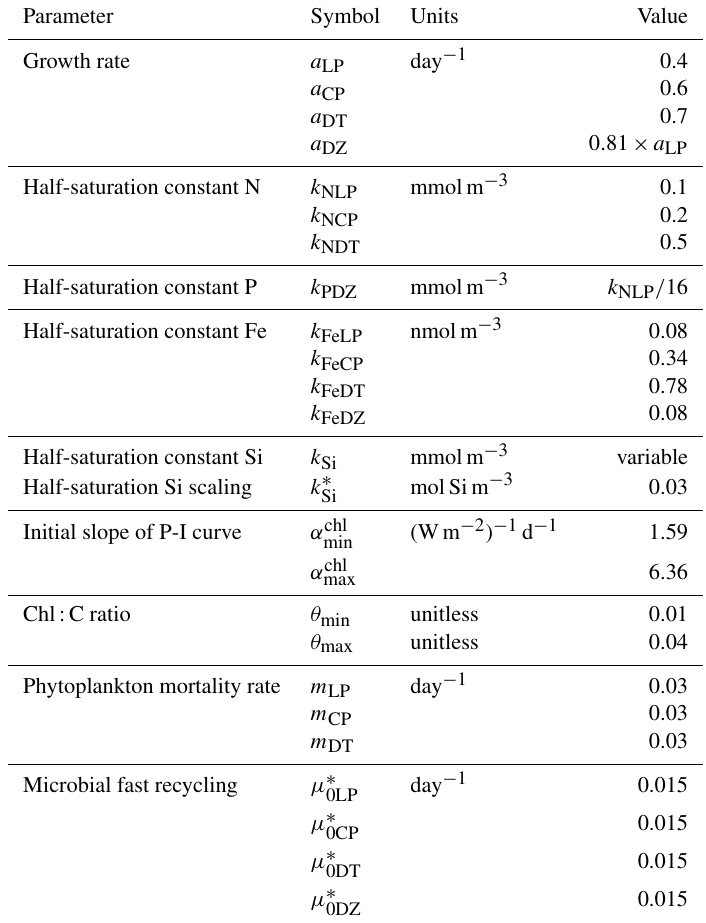
Table 3. KMBM3 phytoplankton production and mortality parameters.